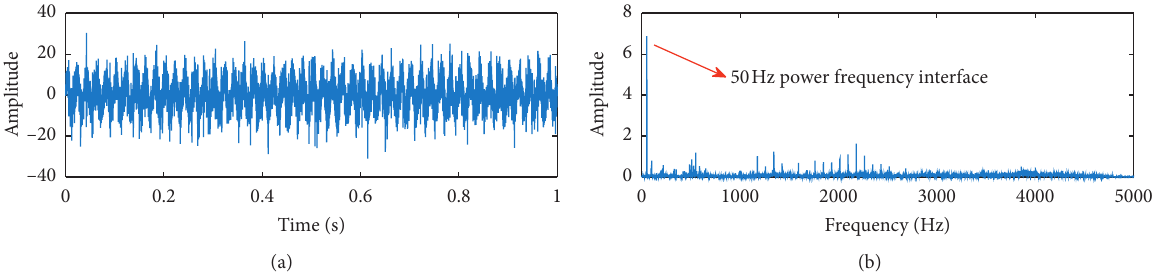
Figure 19: (a) Bearing outer race fault signal and (b) its Fourier spectrum.